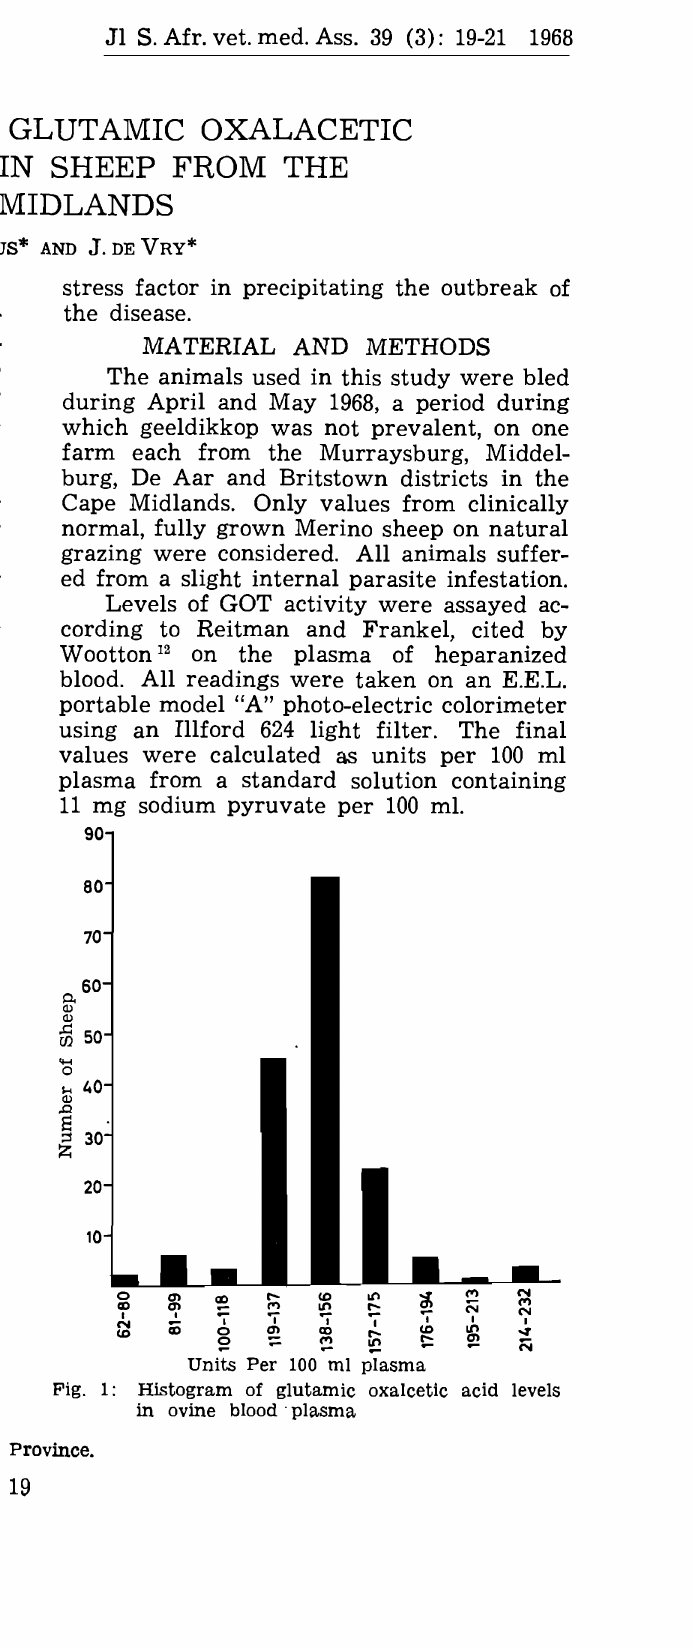
.... .., 0 to ", ~ I N .... to $! ~ ~ t: Units Per 100 ml plasma Fig. 1 : Histogram of glutamic oxalcetic acid levels in ovine blood . plasma